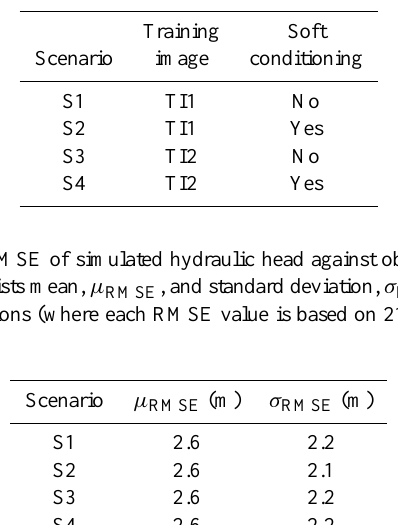
Table 2. Four scenarios of geological realizations used for the multiple-point geostatistical simulations.